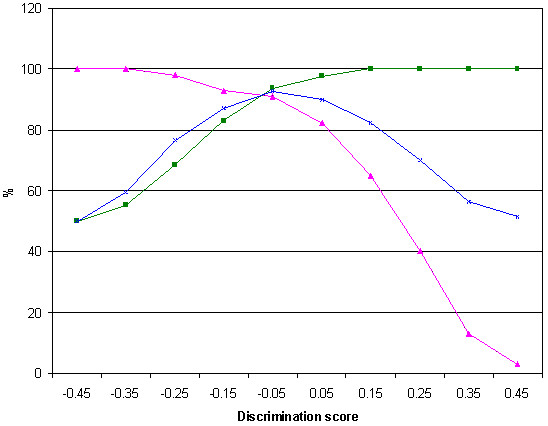
TMB-Hunt performance over a range of discrimination scores. Accuracy (x), sensitivity (▲) and PPV(■) of the predictor at range of discrimination score thresholds. The above results were taken for the predictor discriminating between bbtm and non-bbtm proteins, using the 'leave homologues out' cross-validation, with weighted amino acids and evolutionary information for the query sequence. Similar patterns were found with all settings i.e. using weighted amino acids, no evolutionary information, 'leave homologues out' cross-validation and discriminating between bbtm and ntm proteins.